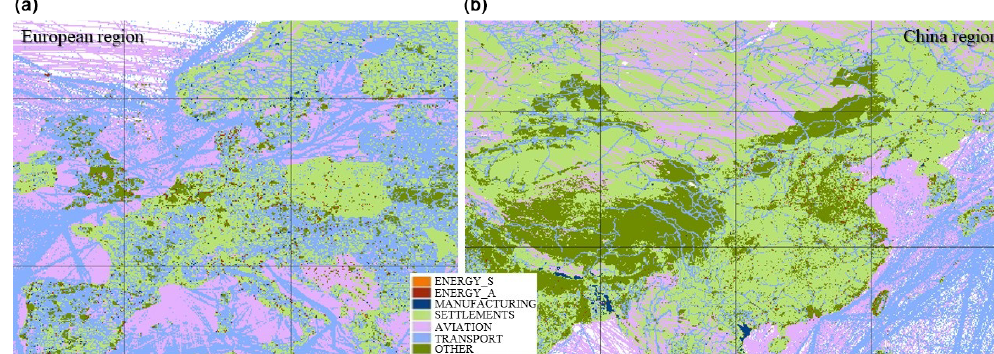
Figure 5. Main emission group that contributes to the total uncertainty per grid cell – European (a) and China (b)